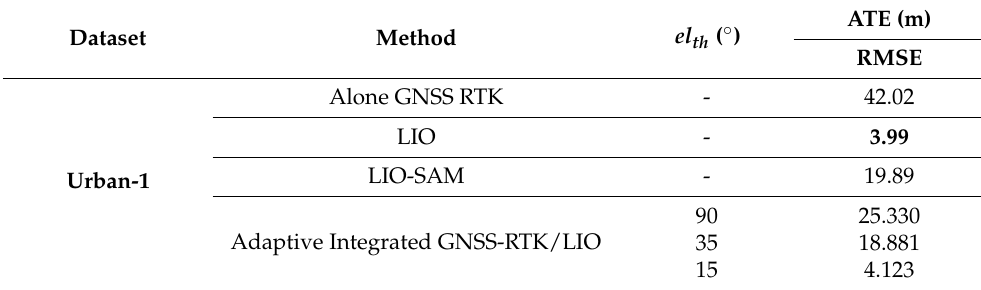
Table 3. ATE of the trajectory estimated by different pipelines on urban-1.